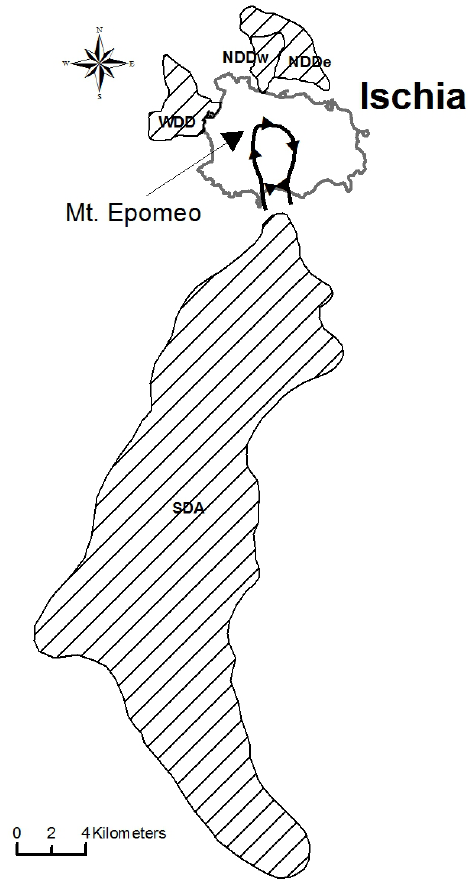
Fig. 12. Main submarine mass movements that occurred offshore of the island of Ischia (simplified and redrawn af- ter Chiocci and De Alteriis, 2006; De Alteriis and Violante, 2009). SDA = Southern Debris Avalanche; WDD = Western De- bris Deposit; NDD e = Northern Debris Deposit (eastern part); NDD w = Northern Debris Deposit (western